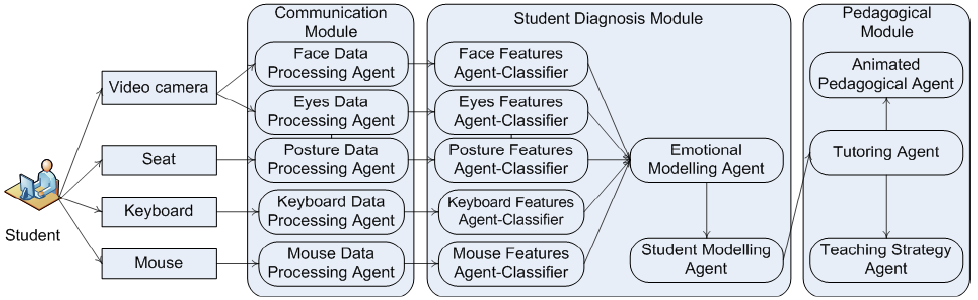
Fig. 5. The set of agents used for design of interaction